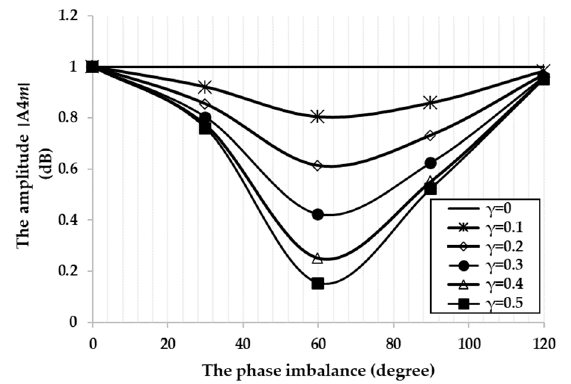
Figure 5. Effect of both optical splitting ratio γ and the phase imbalance φ on the 4 m order sideband.